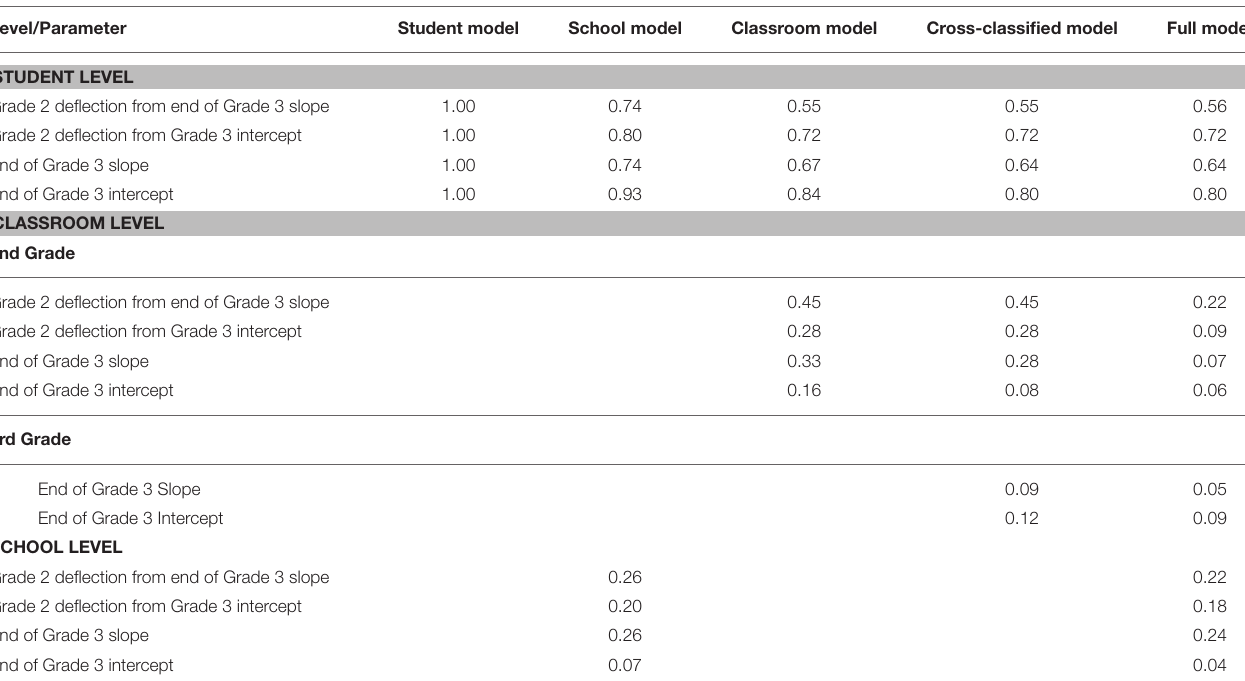
TABLE 5 | Proportion of variance in growth parameters explained at each level ( N = 8367).